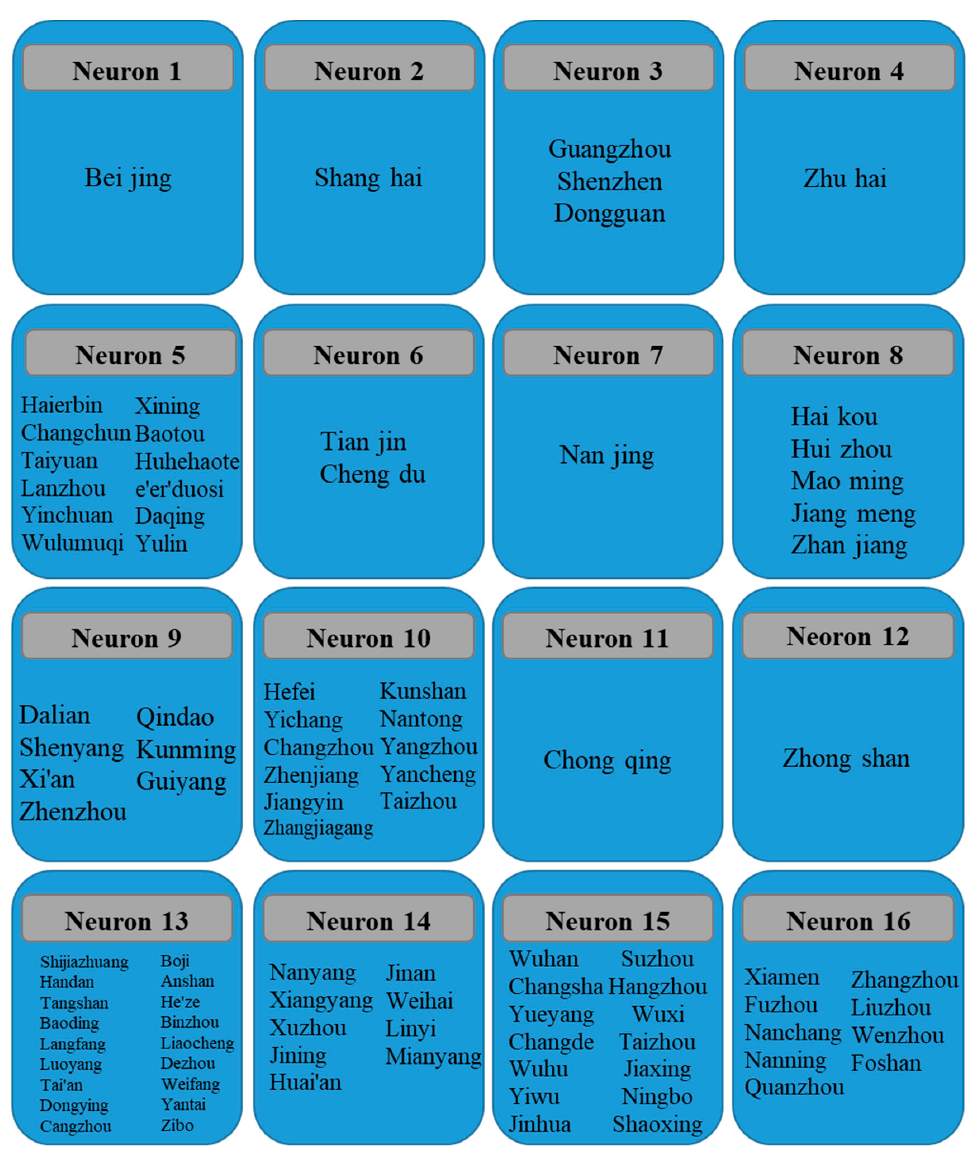
Figure 7. SOM cluster for different cities.